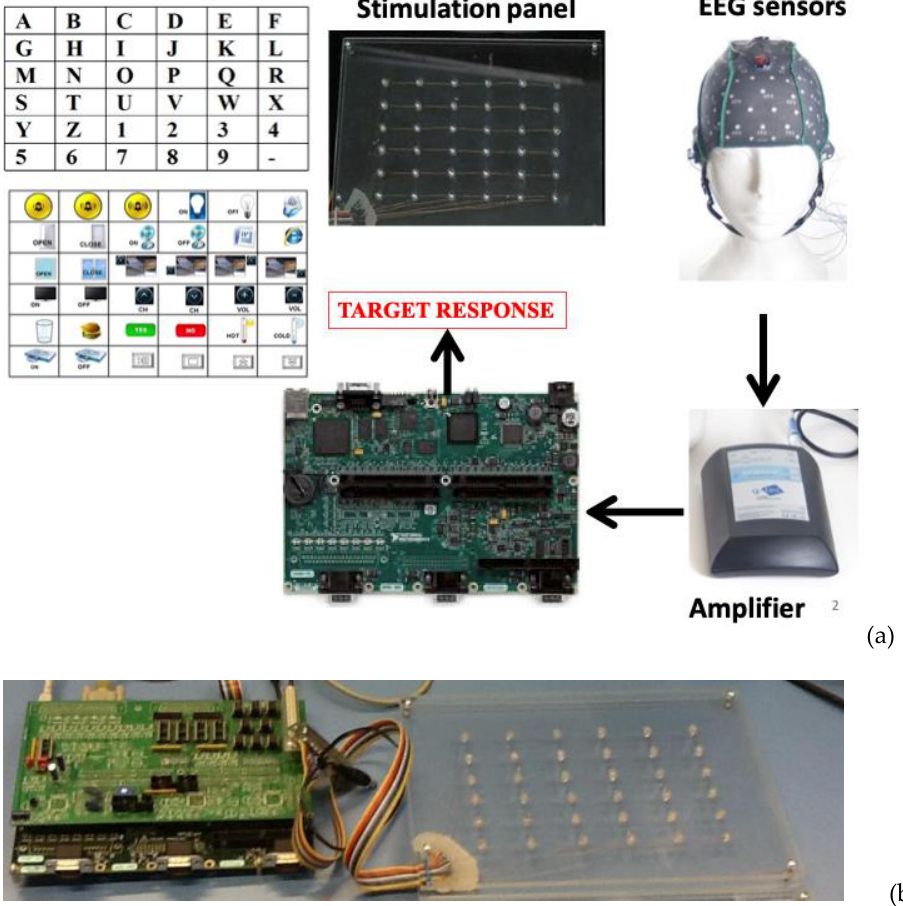
Figure 2. ( a ) Hardware modules of the proposed FPGA-based BCI system; ( b ) stimulation panel and embedded-FPGA-based board. embedded-FPGA-based